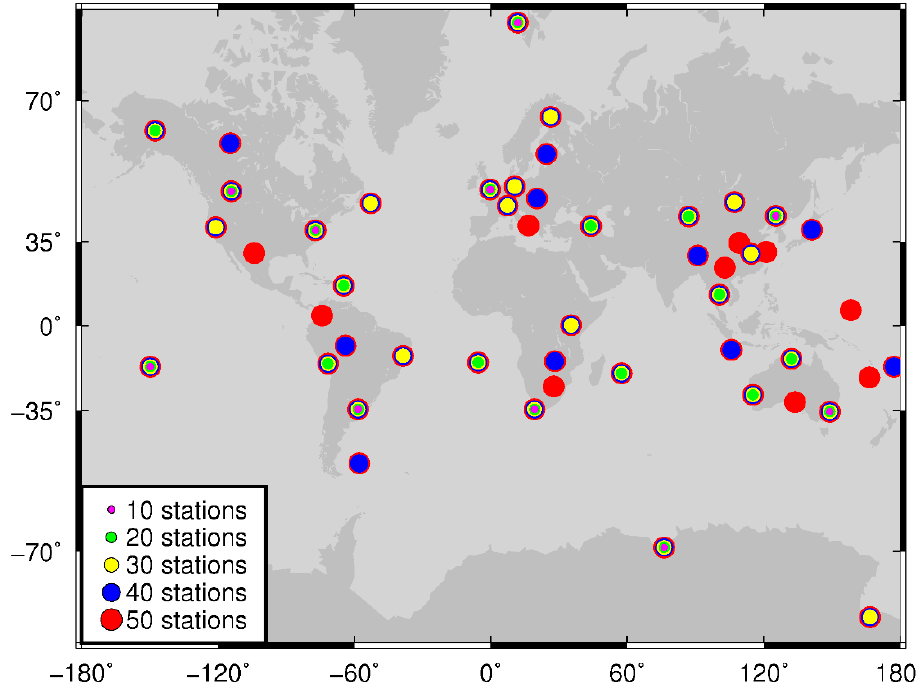
Figure 6. Distribution of stations with different station selection schemes. Purple, green, yellow, blue, and red represent different tracking networks.